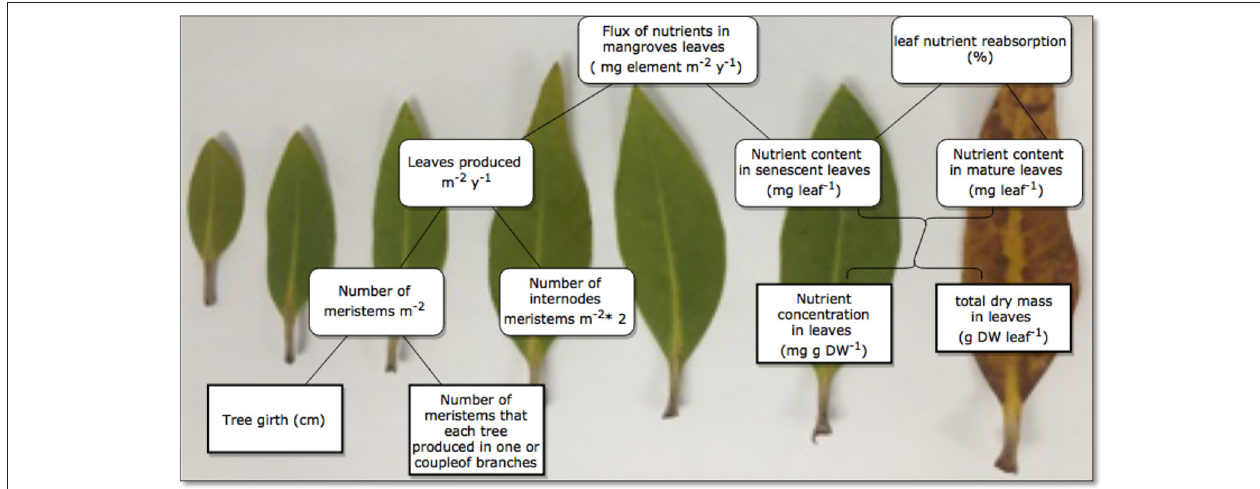
FIGURE 2 | Diagram of calculations used to estimate leaf export flux (mg element m − 2 year − 1 ) and leaf nutrient resorption (%).